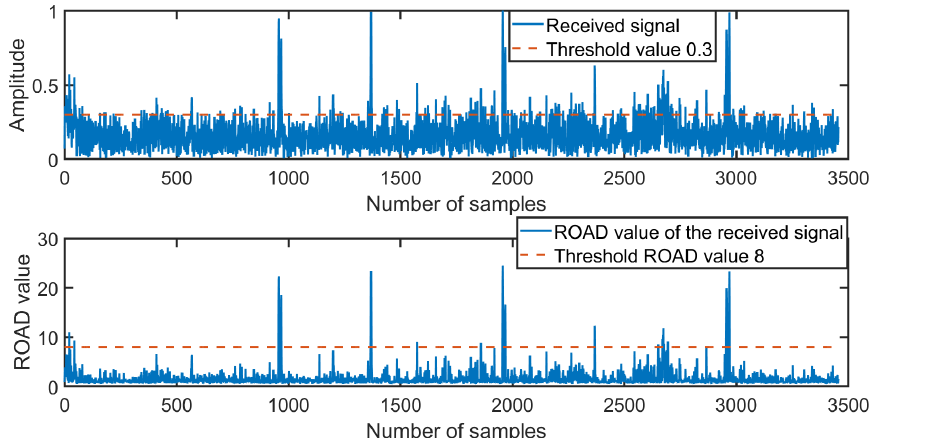
Figure 10. Amplitude of the received signal without interference mitigation and ROAD value of the received signal for an SNR of 0